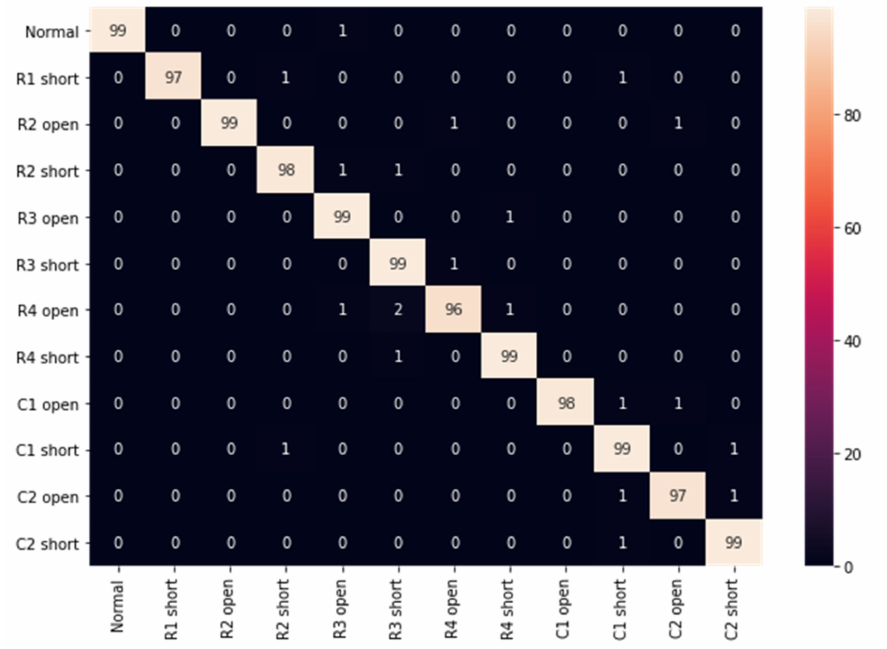
Figure 9. The confusion matrix of the proposed fuzzy logic classifier. Based on the evaluating values in the confusion matrix of the fuzzy logic classifier, the f-score is calculated for each fault class as shown in Table 4. Table 4. The obtained f-score for each fault class. Fault Class Precision Recall F-Score Normal 0.99